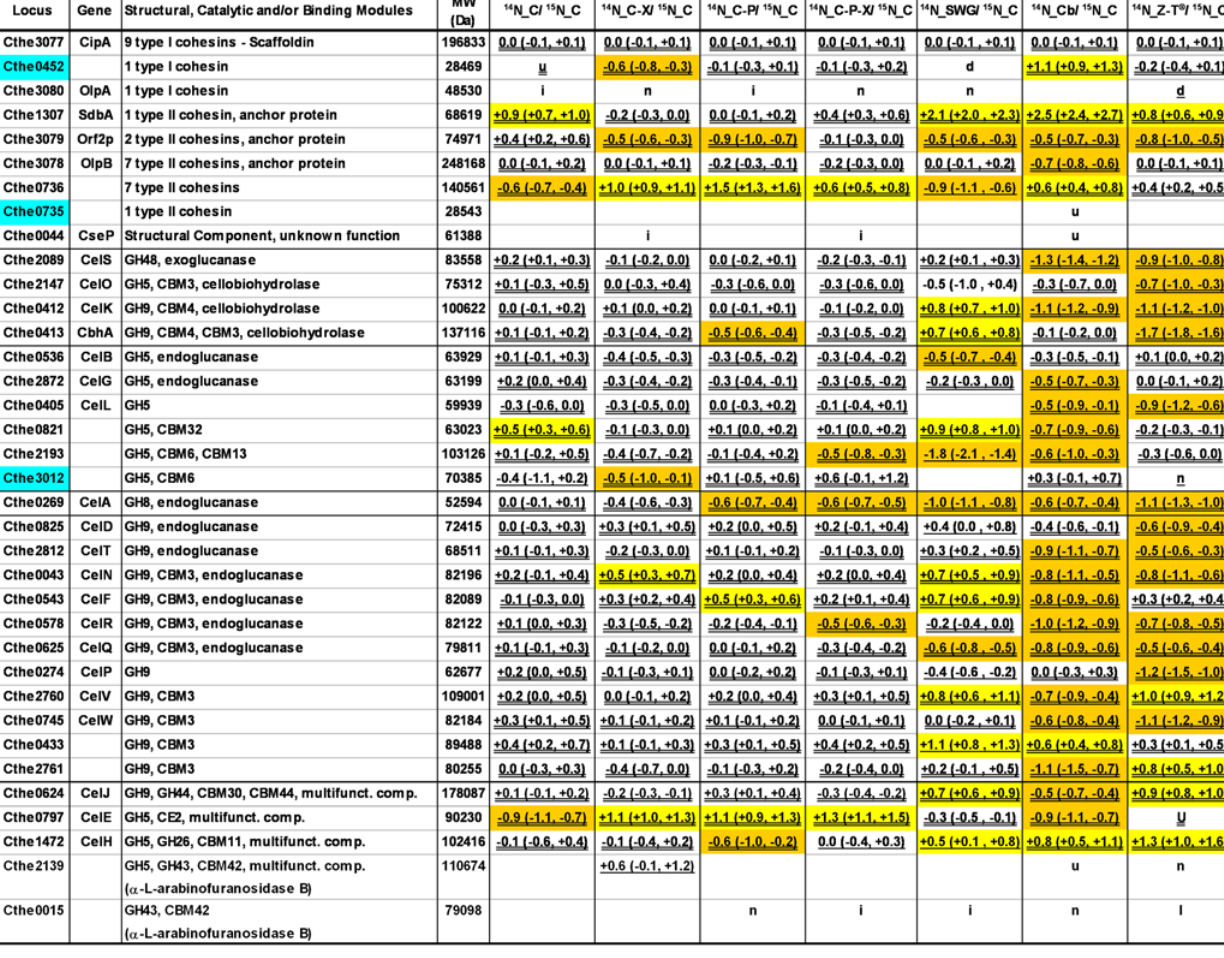
Figure 5. Quantitative changes in Clostridiumthermocellum cellulosome composition in response to carbon substrate – Part I (see Figure 6